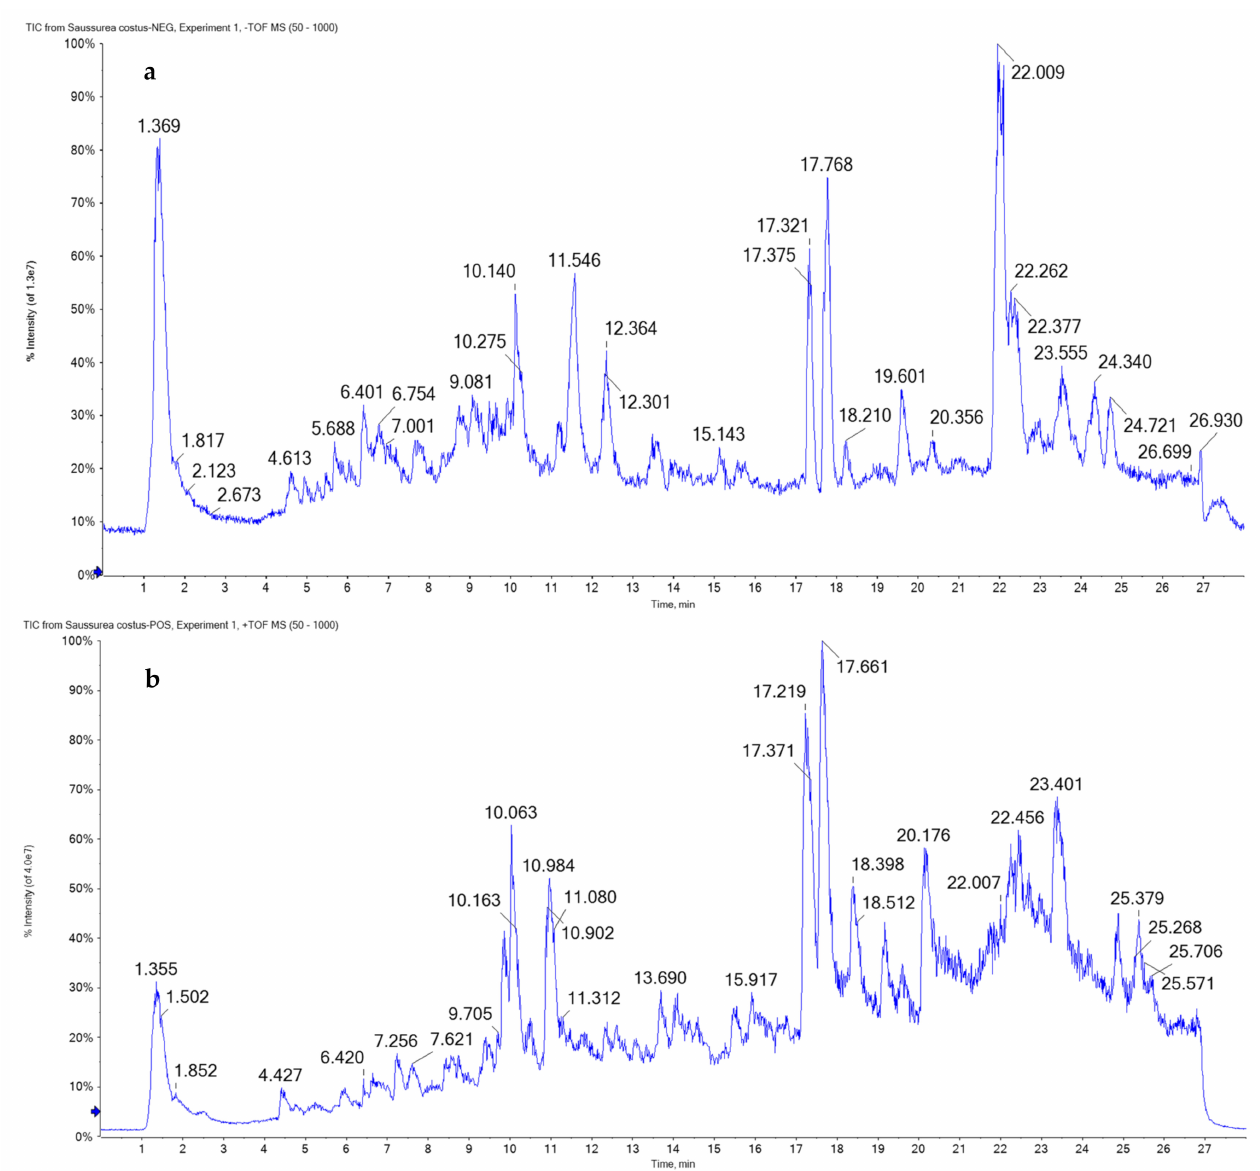
Figure 1. UPLC/T-TOF–MS/MS chromatograms of methanol extract of Saussurea costus roots in negative ( a ) and positive ( b ) ionization